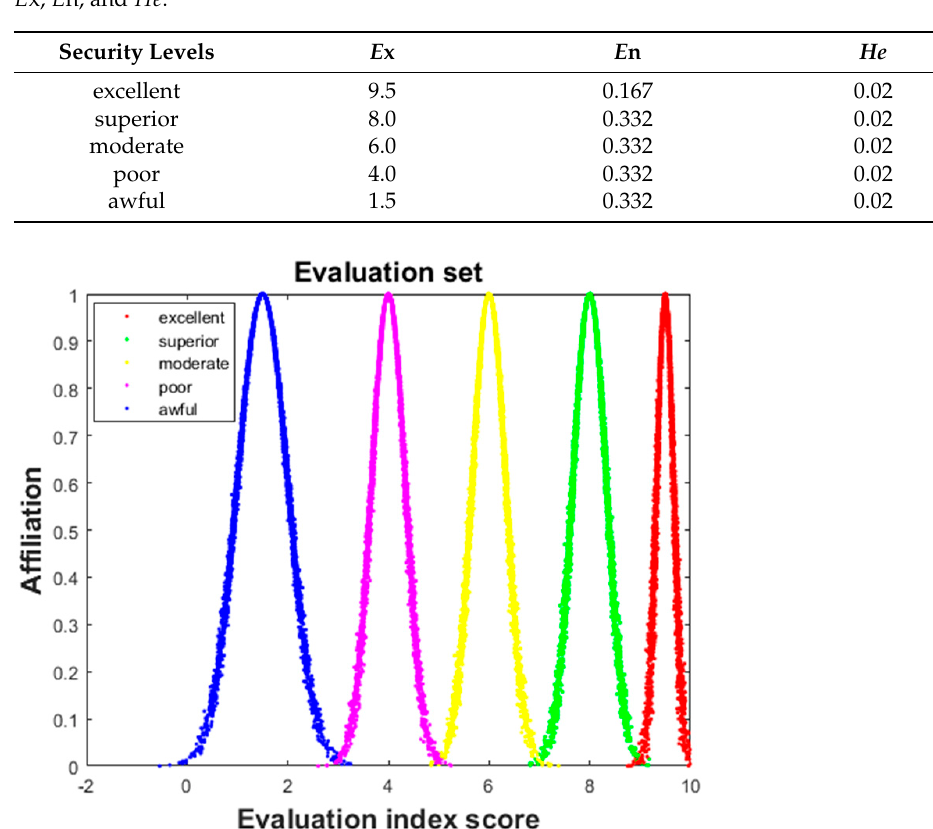
Figure 2. Cloud model with different security levels. Different color point sets represent different security levels: the red represents “excellent”, the green represents “superior”, the yellow represents “moderate”, the purple represents “poor”, and the blue represents